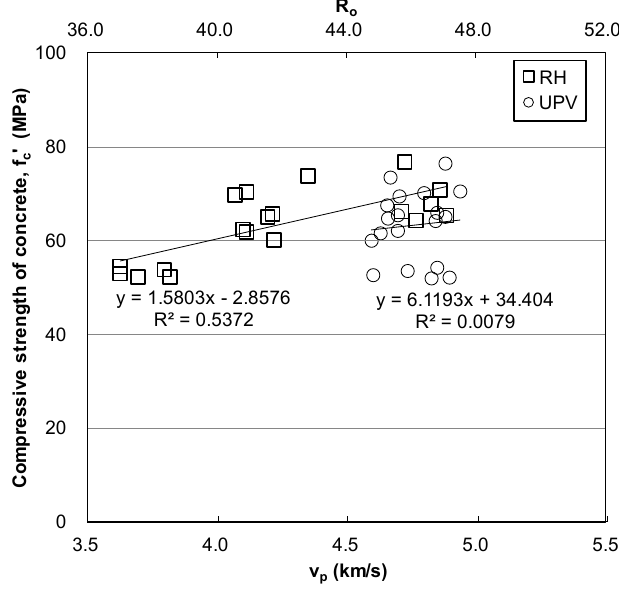
Figure 3. Relationship between tested compressive strength of concrete cylinder and predicted by the non ‐ destructive test.